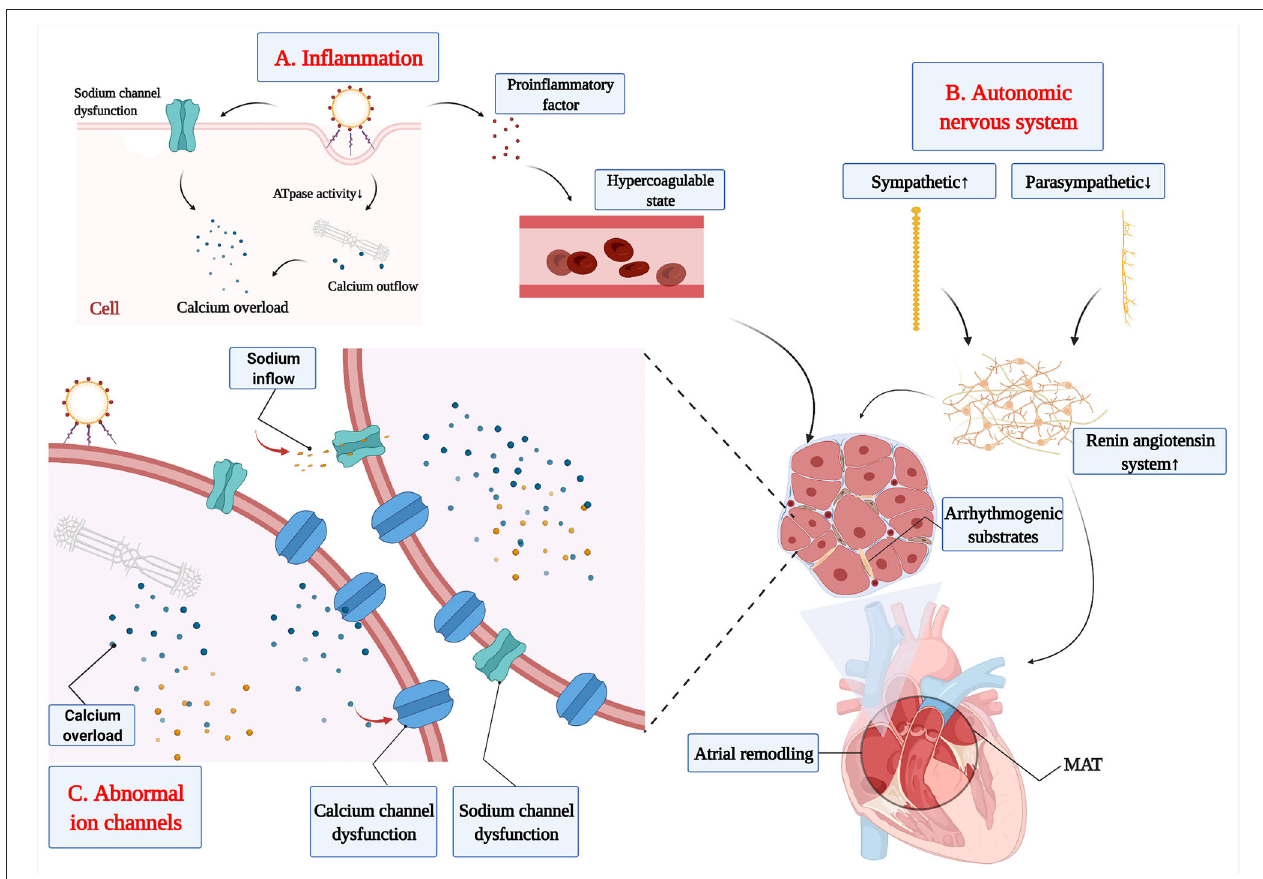
FIGURE 1 | The etiopathogenesis of MAT. (A) The release of proinflammatory factor from inflammation increases the risk of MAT through hypercoagulable state and dysfunction of myocardial cell. (B) The disorder of the autonomic nervous system increases the activation of the renin-angiotensin-aldosterone system to promote the development of arrhythmogenic substrates. (C) The calcium channel and sodium channel dysfunction promote the development of arrhythmogenic